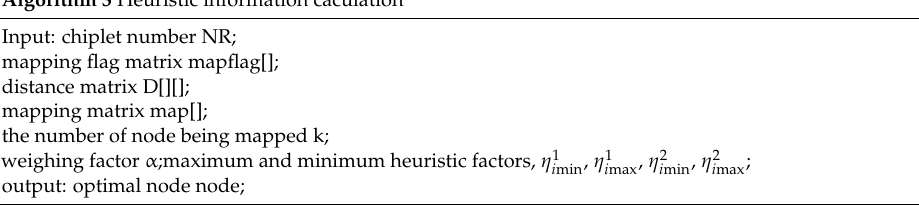
Algorithm 3 Heuristic information